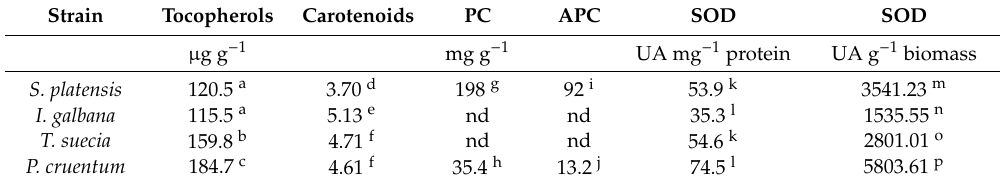
Table 4. Antioxidant concentrations in batch culture: tocopherols, carotenoids, phycocyanin (PC), allophycocyanin (APC), and superoxide dismutase (SOD) content in S . platensis , I . galbana , T . suecica,